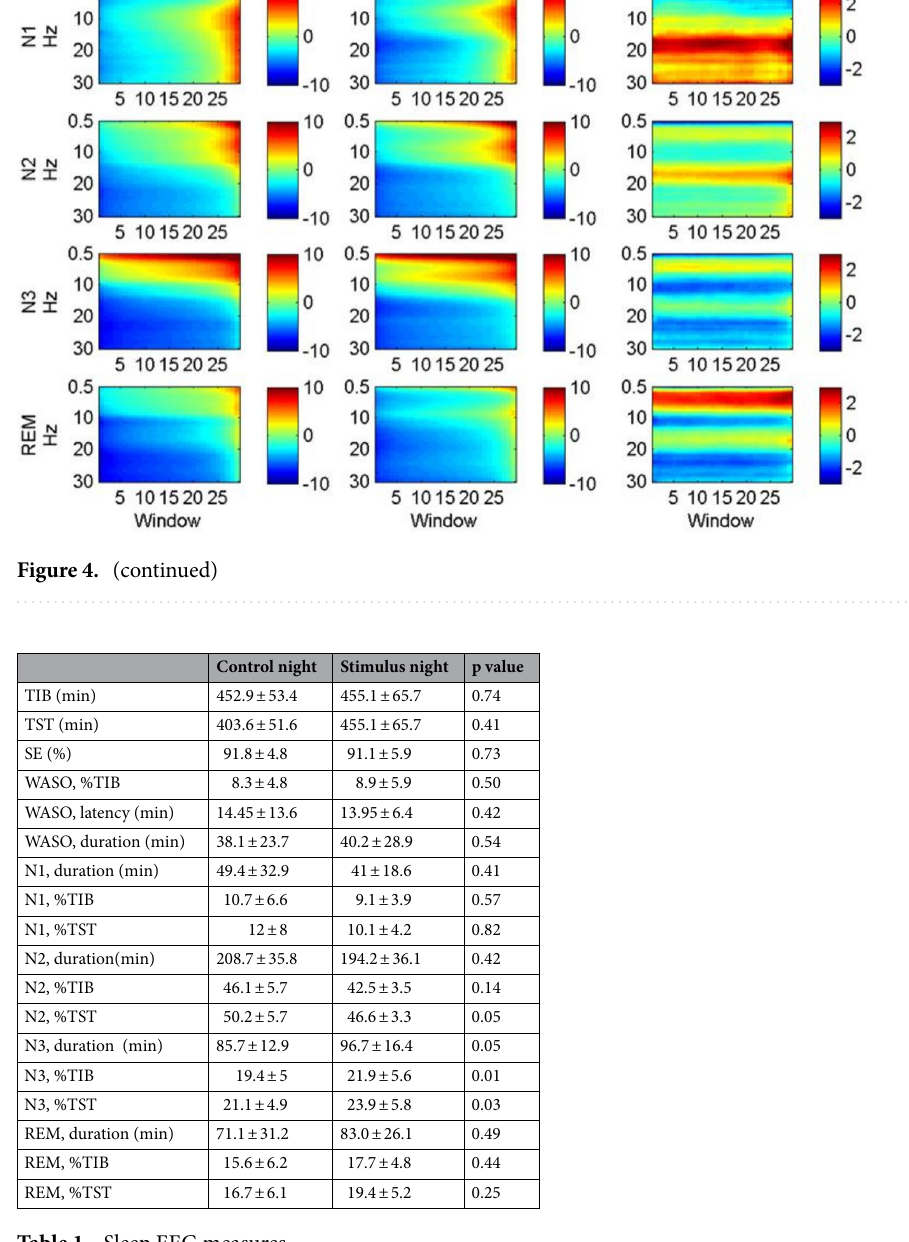
Table 1. Sleep EEG